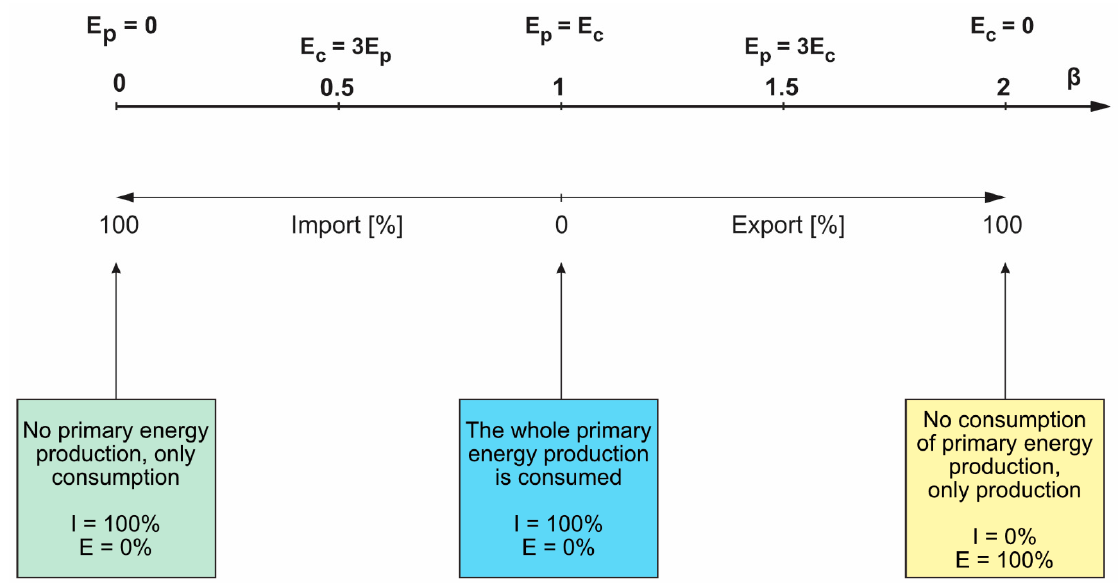
Figure 2. Illustration describing the meaning of the Butlewski coefficient β . I—import; E—export; E p —primary energy production in a particular region or country; E c —total energy consumption in the region or country.